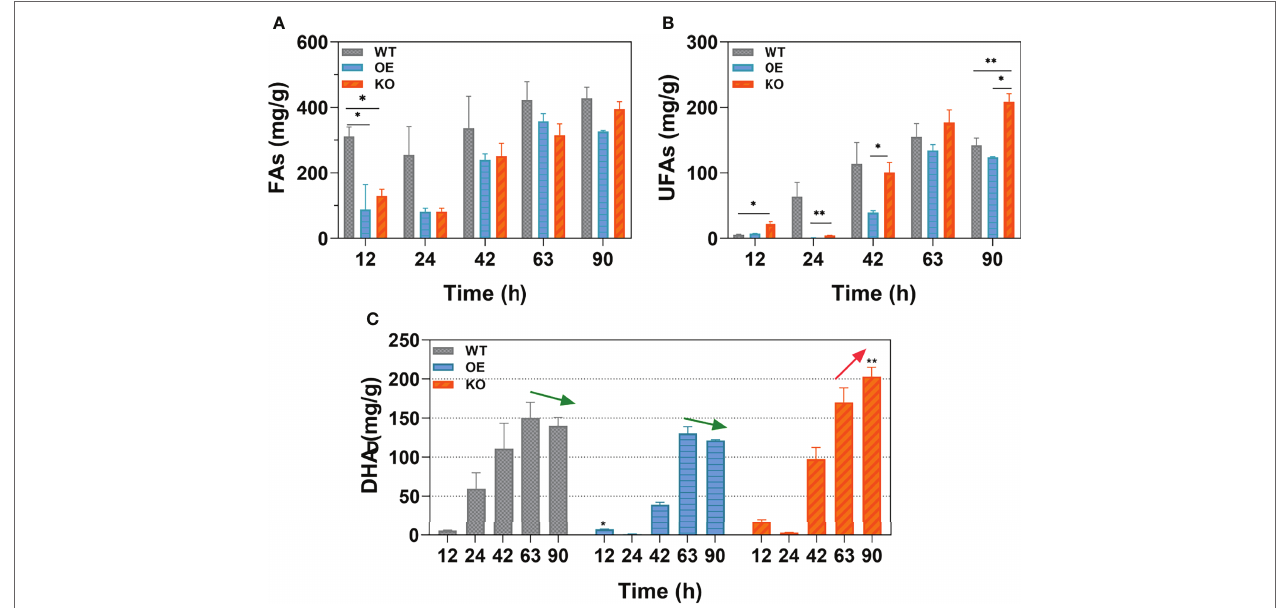
FIGURE 5 | The yield of different types of fatty acids. (A-C) are the contents of total fatty acids (TFAs), unsaturated fatty acids (UFAs), and docosahexaenoic acid (DHA) respectively. Data shown are the weight of fatty acids per gram dry cells weight (DCW). Arrows (green and red) indicate the trend in DHA yield from 63 h to 90 h. Statistically significant differences between wildtype and transformants (OE and KO) were indicated at the p < 0.05 (*) and p < 0.01 (**) level. Values are the mean ± standard